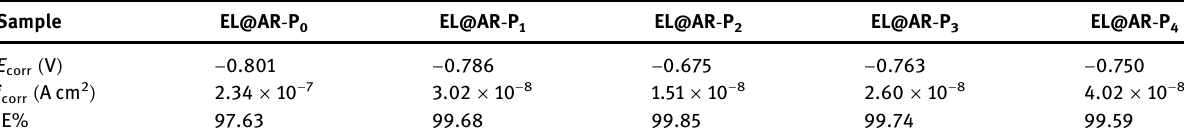
Table 1: Electrochemical test results of coatings with di ff erent PM - 2 usages Sample